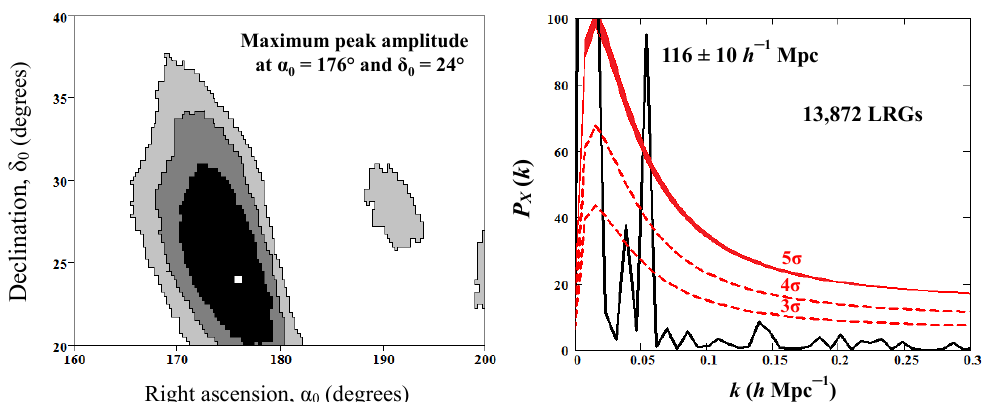
Figure 3. ( Left panel ): Areas of fixed confidence levels of the peaks in 1D power spectra P X ( k ) at k max = 0.054 h Mpc − 1 calculated using Cartesian LRG coordinates projected on various axes X ; the data (corresponding to the sample DR7-Full) are collected for the six sectors shown in Figure 2; points in the α / δ -plane indicate the directions of axes. The colored areas are: light gray— ( 3 σ ) , intermediate grey— ( 4 σ ) and dark grey— ( 5 σ ) ; the white square indicates the direction of the maximum spectral peak height ( α 0 and δ 0 ). ( Right panel ): 1D power spectrum with maximum peak ( k = k max ) calculated for the projections on X 0 -axis ( α 0 , δ 0 ) of the Cartesian LRG coordinates registered through the same six sectors; significance levels 3 σ and 4 σ (dashed lines) and the narrow band 5 σ are plotted similarly to the levels and band in the right panel of Figure 2 (see text).